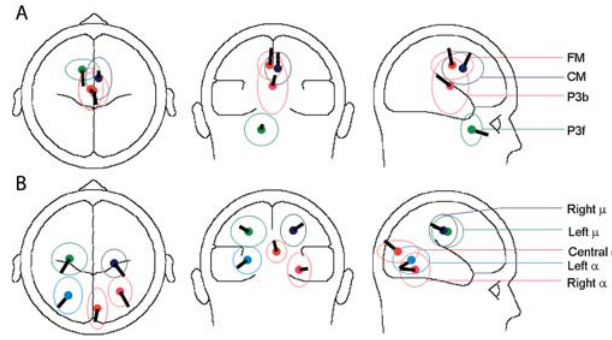
Figure 5. Mean Component Cluster Equivalent Dipole Locations The mean scalp map for each of the nine component clusters could be well fit by a single equivalent dipole (mean residual variance: 4.8%). The figure shows the locations and orientations of these dipoles, as determined by BESA, plotted on the spherical head model, with ellipses showing the spatial standard deviations of the locations of the equivalent dipoles for the individual components in the cluster. DOI: 10.1371/journal.pbio.0020176.g005